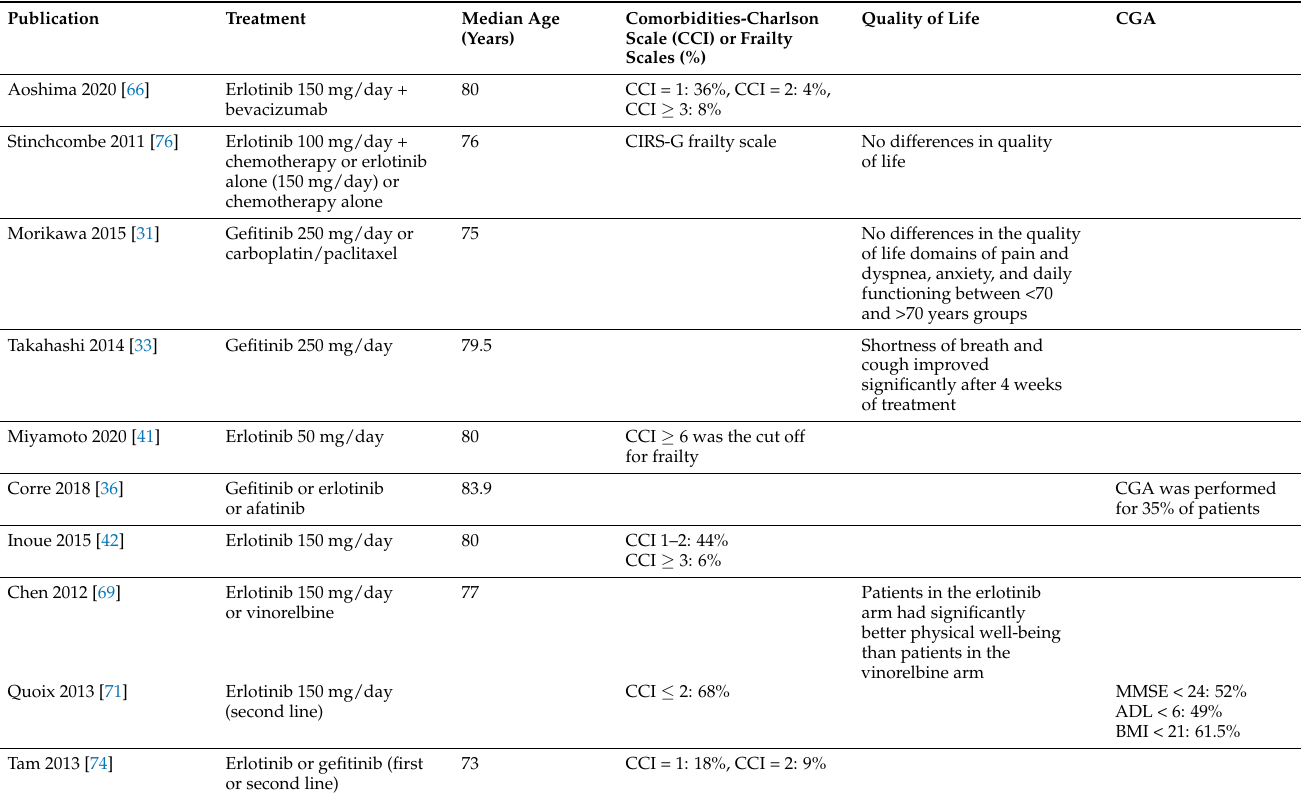
Table 8. Geriatric assessment and quality of life results in older patients in randomized and non- randomized